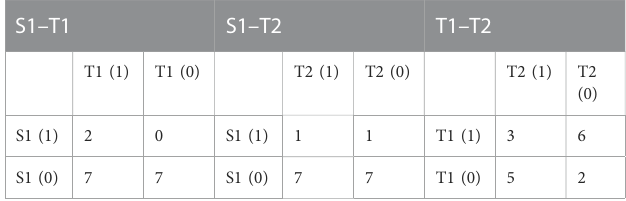
TABLE 6 Contingency tables of GI asymmetry occurrence in diastolic blood pressure in the vasovagal patients ’ group. Diastolic blood pressure asymmetry occurrence is marked as 1, absence as 0. Head-up tilt test phases: S1, supine; T1, tilt (initial 3 min); and T2, pre-syncope 3